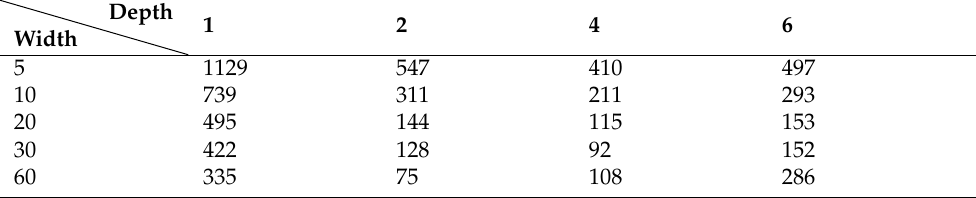
Table 3. The training time (s) for different neural network